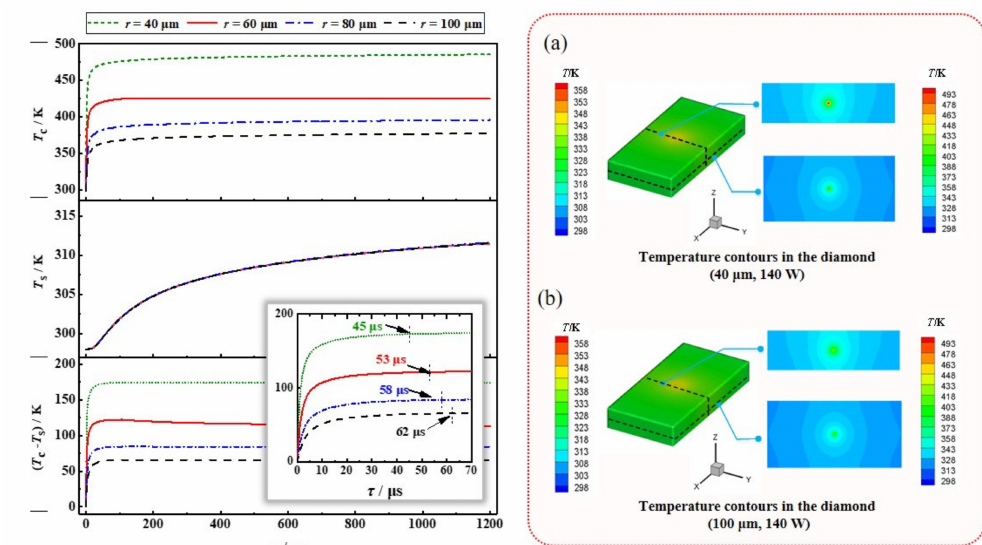
Figure 3. Temperature variation of diamond with different thermal radius in the heating process (top: center, middle: upper surface, and bottom: the difference). Inset: the temperature contours in the diamond with the absorbed power of 140 W and heat source radius of ( a ) 40 µ m, and ( b ) 100 µ m,